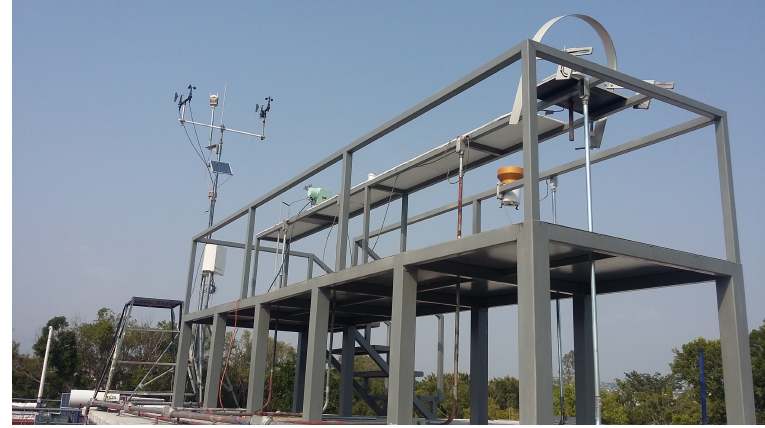
Figure 2. ESOLMET weather station, IER, Temixco, Morelos